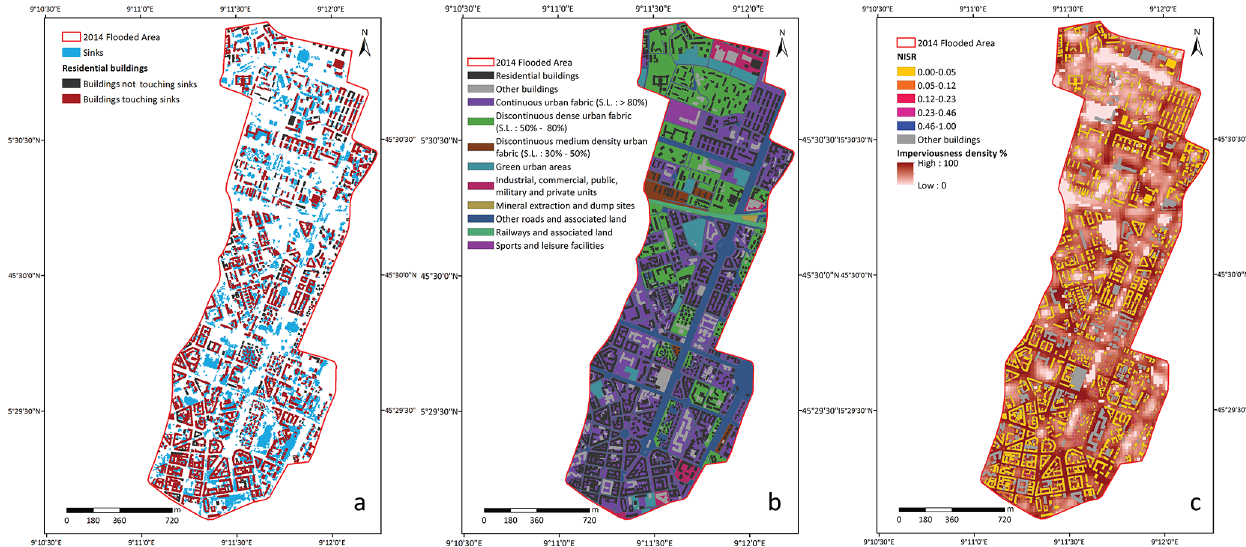
Figure 4. (a) Sink distribution map (touching sinks in red; non-touching sinks in grey). (b) Urban Atlas 2018 map (residential buildings in black; other buildings in grey). (c) Copernicus Imperviousness Density map resampled at 5m and NISR distribution for residential buildings. Built-up-area shapefile is from © OpenStreetMap contributors 2022. Distributed under the Open Data Commons Open Database License (ODbL) v1.0. Base maps in (b) and (c) are from © European Union, Copernicus Land Monitoring Service 2022, European Environment Agency (EEA). Table 4. The average, minimum and maximum economic unit value for each residential building structural vulnerability class. Vulnerability Average